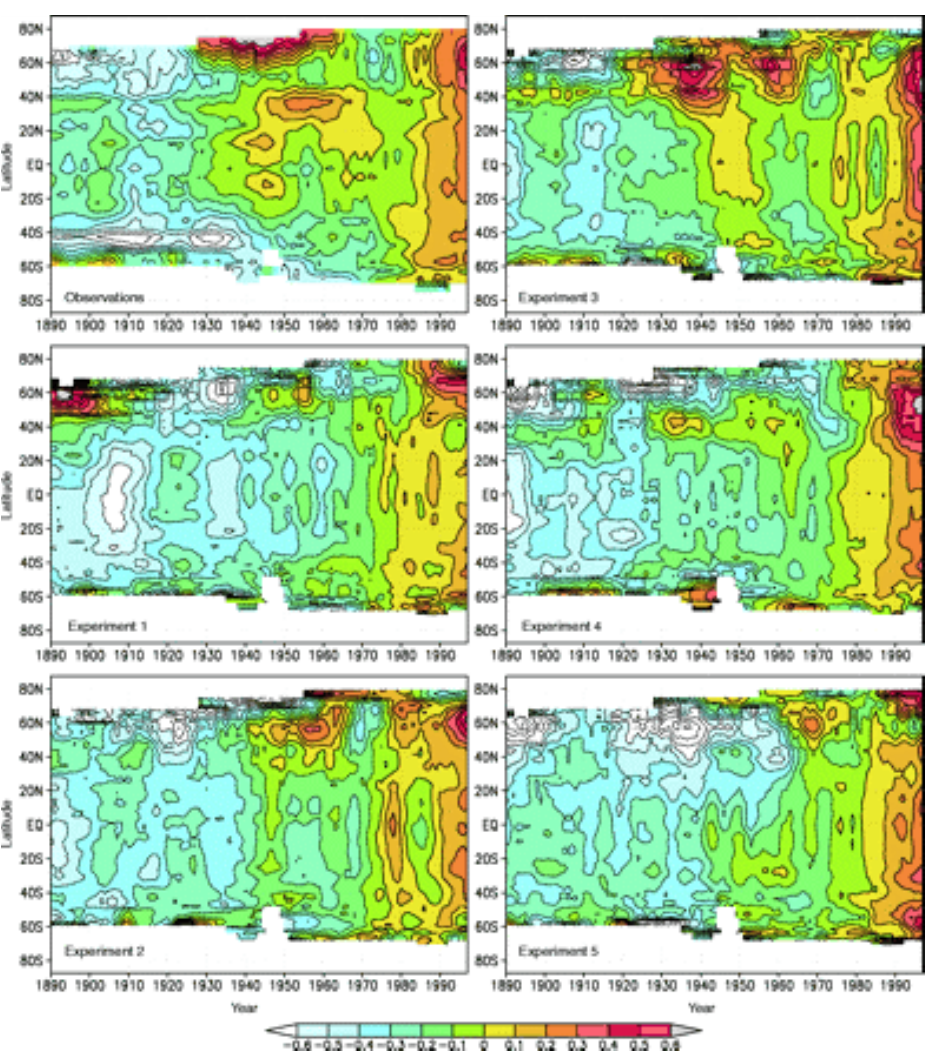
FIGURE 23. Zonal mean anomalies of surface temperature (in °K) for observations and the five numerical experiments as labeled. Note the experiment agrees fairly well with the observations. ozone, sulfur dioxide with the emission, transport, oxidation and removal of sulfur species treated. Indirect aerosol forcing was also represented. Natural forcings were stratospheric aerosols following volcanic eruptions and spectrally resolved solar irradiance changes. This ensemble was then compared with two others, one with only natural forcing and one with only anthropogenic. These were called ALL, ANTHRO and NATURAL. Fig. 25 shows the results of these simulations. NATURAL reproduces the first half of the 20 th century but not the second, largely because of multi-year cooling from three volcanoes, as well as lack of AGHG forcing. ANTHRO misses the first half but gets the second. The two together in ALL succeed in reproducing the entire record fairly well. The ALL simulation is then extended through the 21 st century driven by the IPCC’s Special Report on Emissions Scenarios, B2, which assumes a more modest increase in GHGs than previously assumed. Stratospheric ozone is assumed to recover as stratospheric chlorine loading diminishes, and natural forcings are assumed to remain at 1999 levels (high solar, no volcanoes). The HadCM3 model has significant “climate sensitivity” and predicts a 2.7°C temperature rise between 1945 and